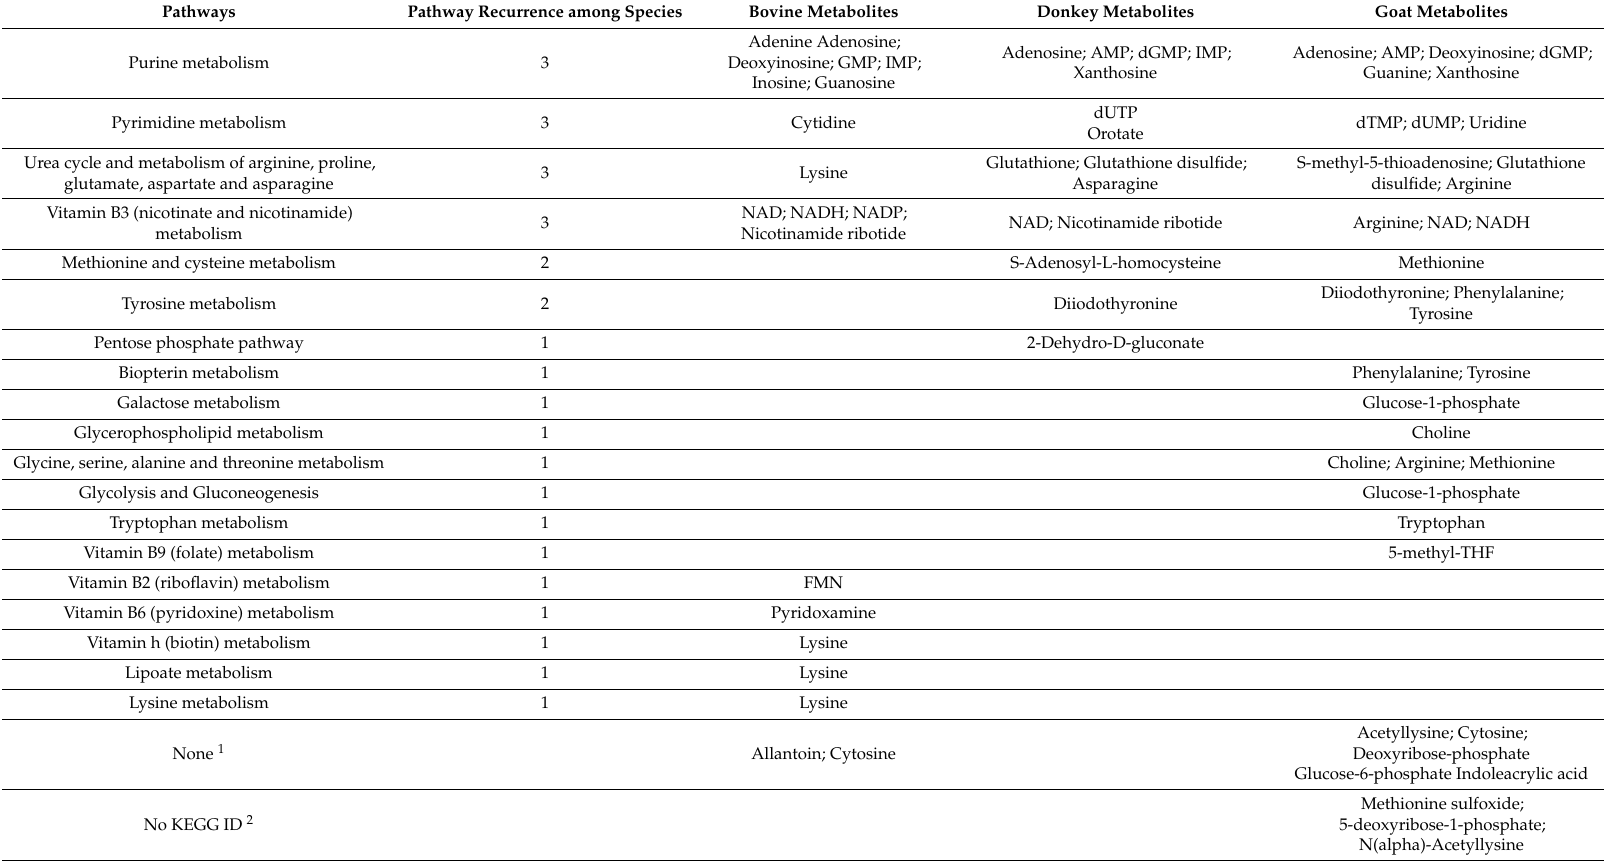
Table 1. Pathways and related MEV metabolites